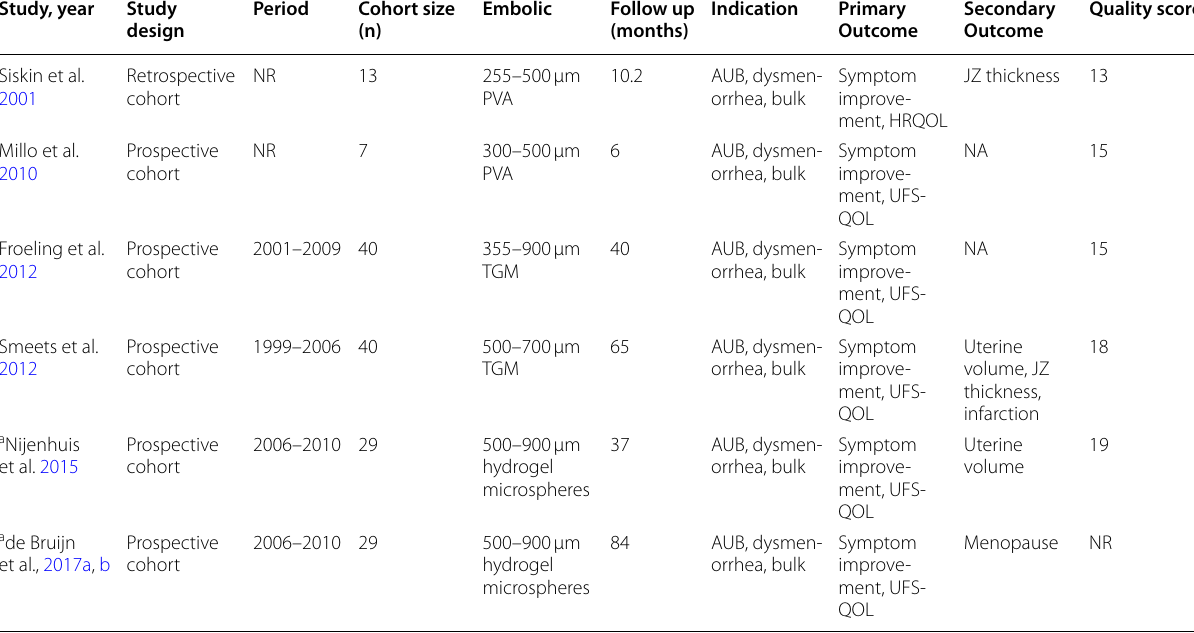
NR not reported, AUB abnormal uterine bleeding, HRQOL health related quality of life, UFS-QOL Uterine fibroid symptom and quality of life a same patient cohort with outcomes reported at 3 years and 7 years. The De Bruijn article was not included in the systematic